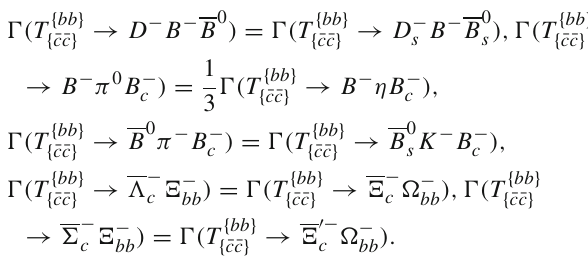
{ bb } Table11 Tetraquark T {¯ c ¯ c } decaysintosinglycharmedbaryonanddou- bly bottom baryon for the transition ¯ c → ¯ q 1 q 2 ¯ q 3 . In particular, the amplitudes are shown as Cabibbo allowed, singly Cabibbo suppressed, doubly suppressed respectively Channel Amplitude